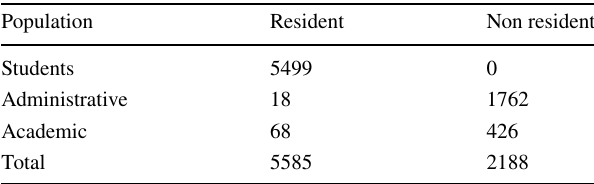
Table 1 Residents and nonresident population in Adama Science and